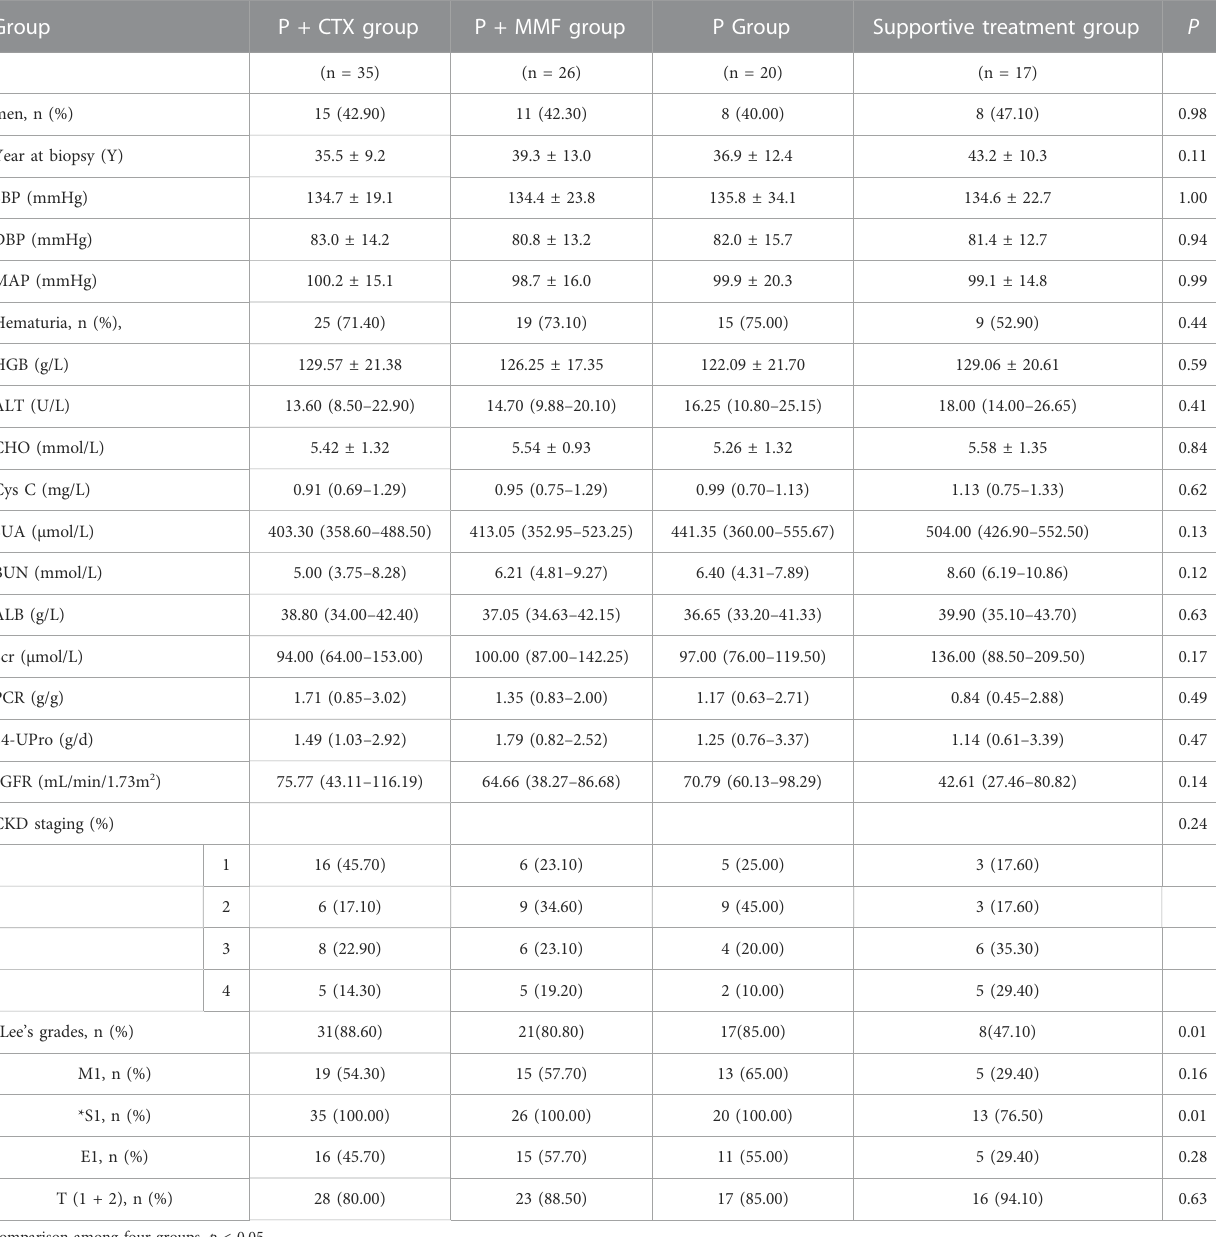
TABLE 1 Comparison of baseline data in different treatment groups for severe IgAN (n = 98).